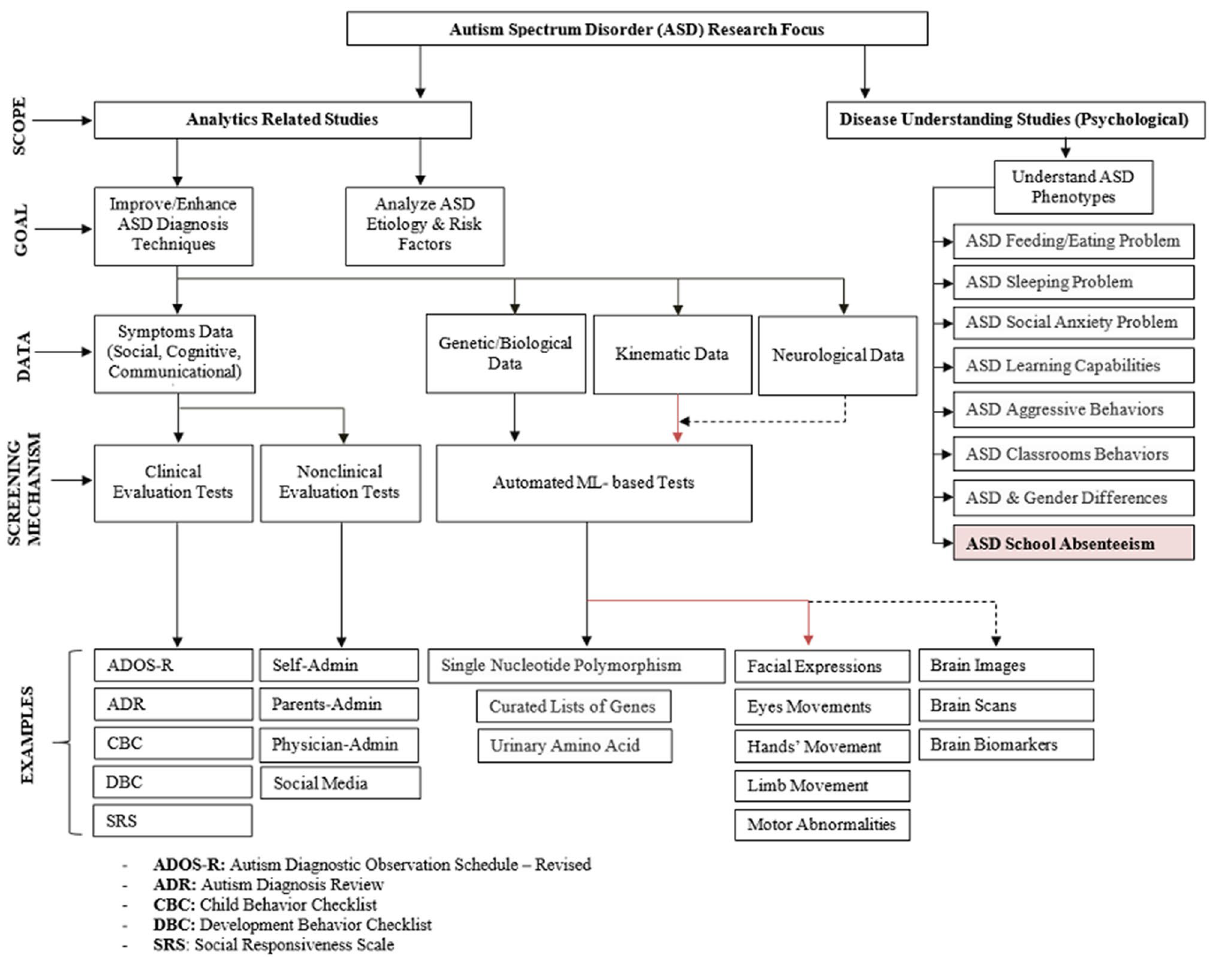
Figure 2. Schematic diagram of ASD literature review. This research focuses on SA as one of the ASD